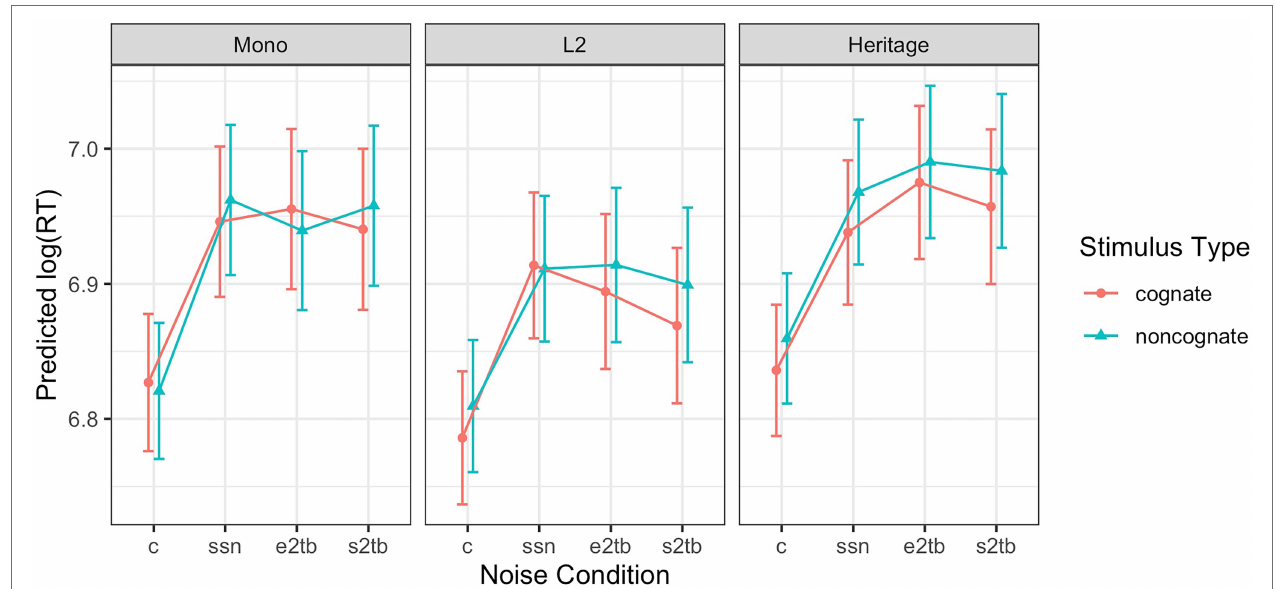
FIGURE 1 | Predicted response times (estimated marginal means with prediction intervals) for correct word trials in the lexical decision task across stimulus types, noise conditions, and participant groups, using the fitted model from Table 4 . (c = clear, ssn = speech-shaped noise, e2tb = English two-talker babble, and s2tb = Spanish two-talker